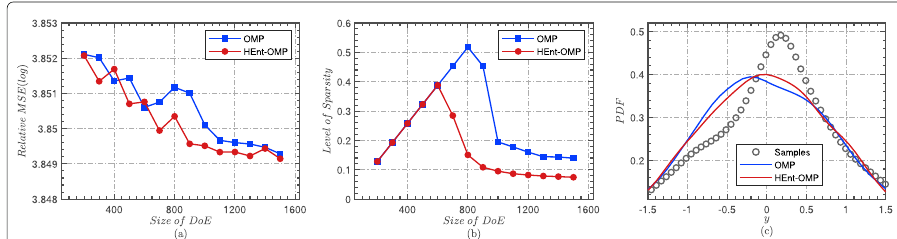
Fig. 10 Performance comparison of OMP, Ent-OMP and HEnt-OMP w.r.t. the high-dimensional function. ( a ) The relationship between the relative MSE and the size of DoE; ( b ) The relationship between the sparsity level of several methods and the size of DoE; ( c ) Enlarged details of the reconstructed PDF